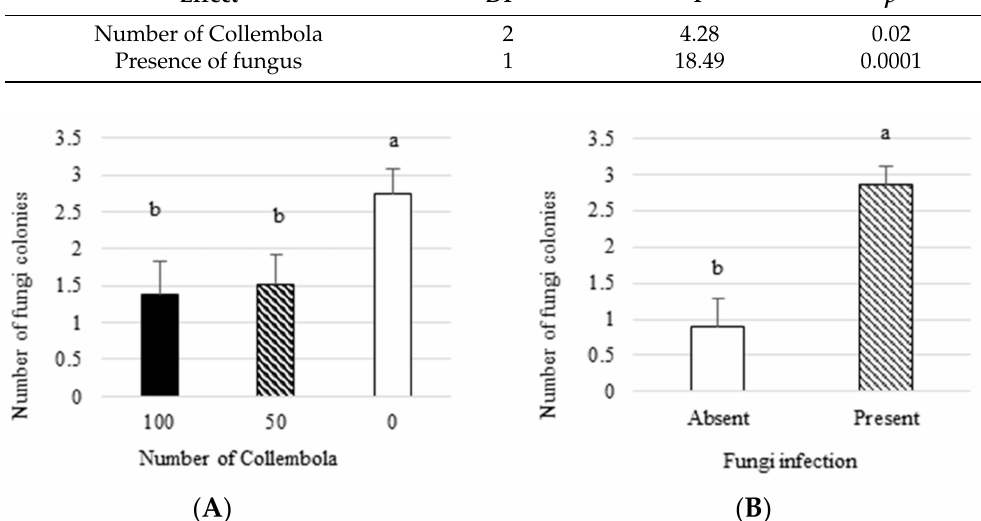
Figure 3. Several Fusarium colonies isolated from plants in three variants of Collembola abundance (100, 50, and 0 individuals) ( A ) and from plants previously infected with fungi and not infected ( B ). The different lowercase letters indicate significant differences between treatments, p ≤